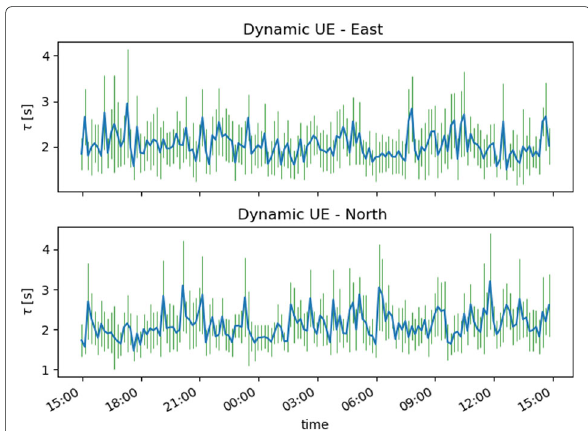
Fig. 15 Correlation time obtained on the basis of simulation results in Loc1 and for the dynamic UE